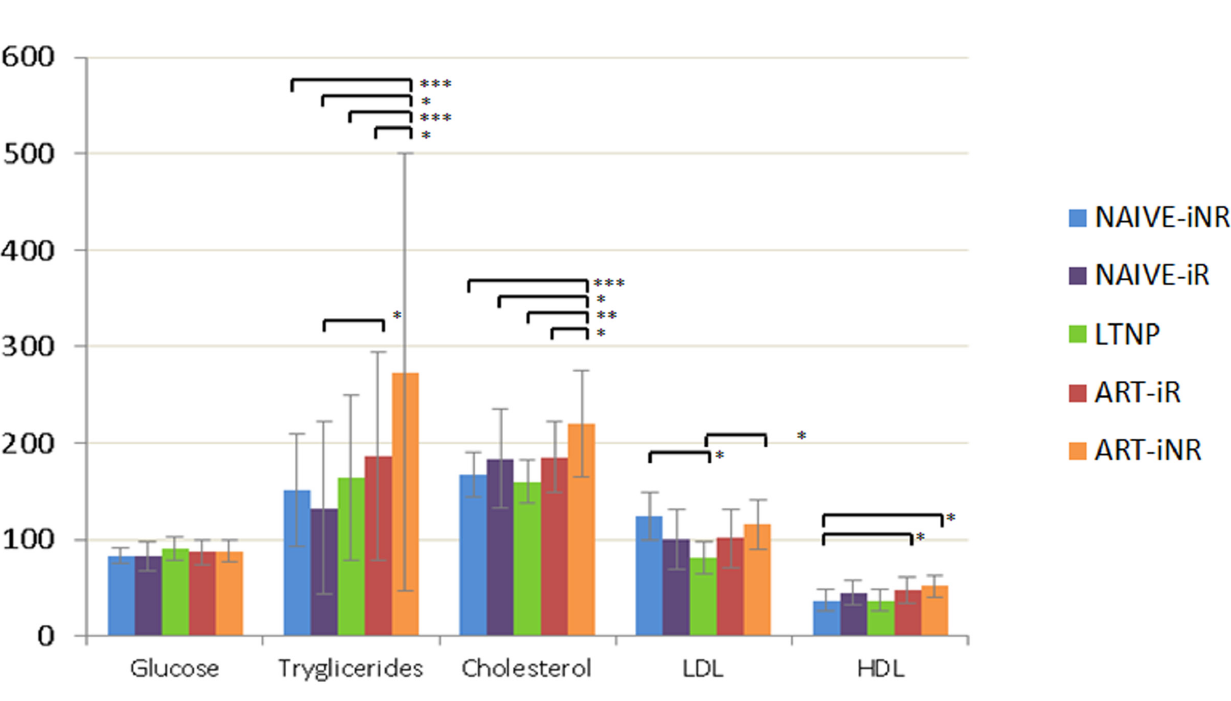
FIGURE 1 - Metabolic variables means in the five HIV-infected groups. Significant difference between the specified groups: * ≤0,05, ** ≤0,005, *** ≤0,0001. Gamma test was used for tryglicerides and Anova and Tukey-Kramer were used for the others. ART: antiretroviral therapy; Naïve: ART-naïve; iR: immunological responder; iNR: immunological non-responder; LTNP: long-term